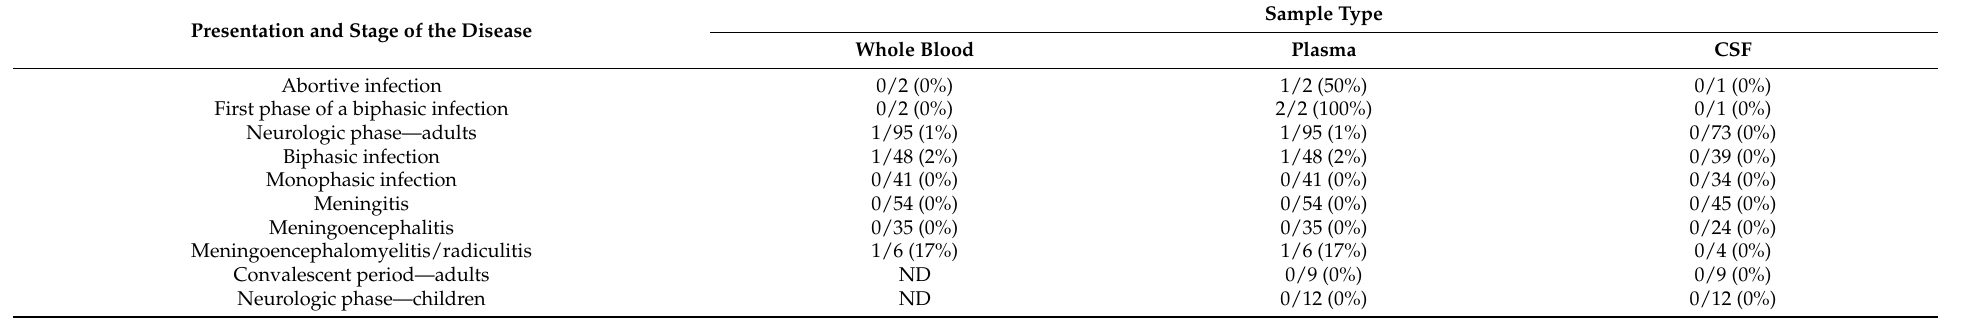
Table 1. The proportion of the positive results of the rtPCR test for TBEV RNA in the study cohort. The number and percentage (in parentheses) of the positive samples per patient group and the type of diagnostic material.